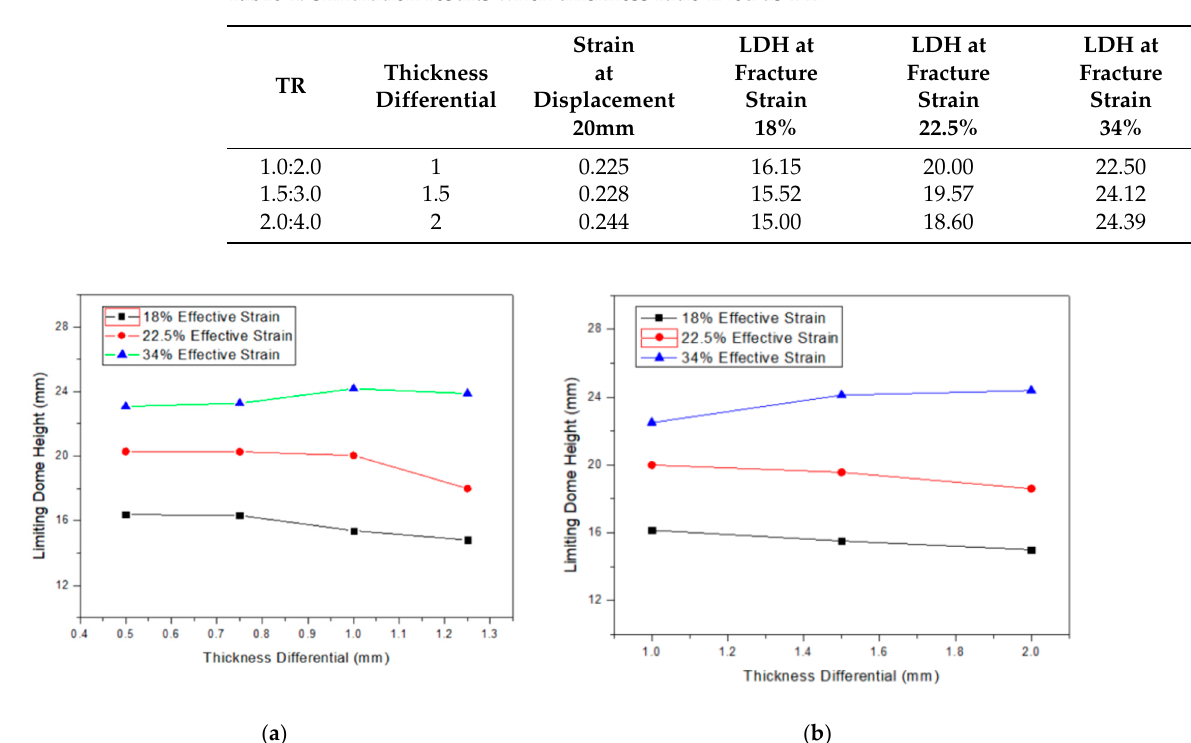
Figure 5. Limiting Dome Height VS Thickness Differential with fixed thickness ratio ( a ) TR = 1.5; ( b ) TR = 2.